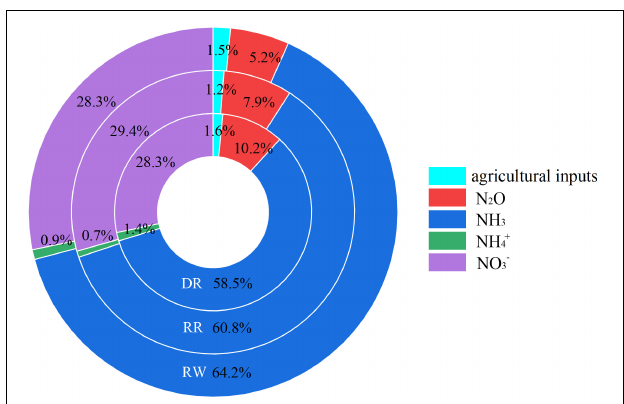
FIGURE 4 | Contribution of different sources to the reactive N emission of the three cropping systems. DR, double-rice system; RR, ratoon rice system; and RW, rice-wheat system.